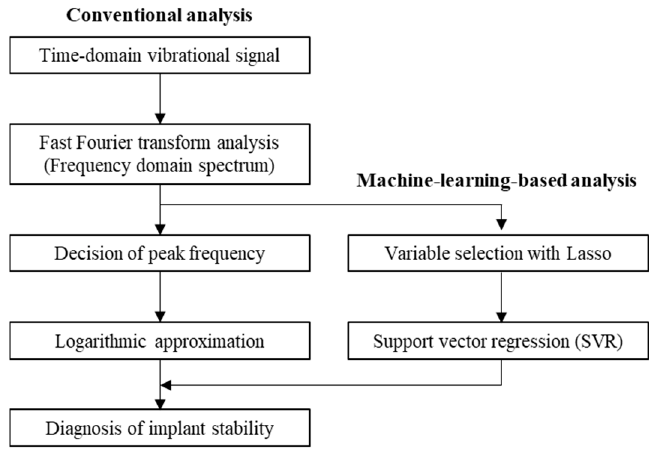
Figure 7. Flowchart of L-RFA analysis scheme for implant stability.